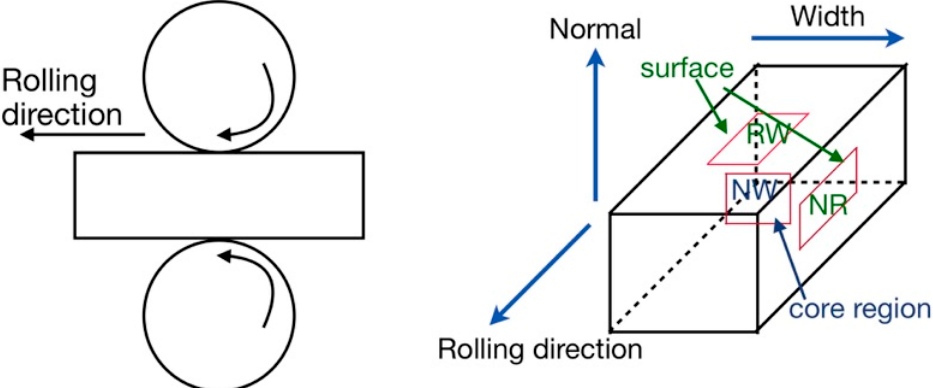
Figure 1. Schematic illustration of cold rolling and regions of normal-rolling (NR), rolling-width (RW), and normal-width (NW) planes for nanoindentation measurements.